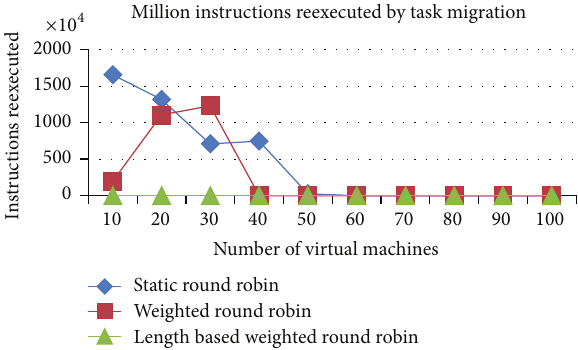
Figure 7: Number of task migrations (time shared).